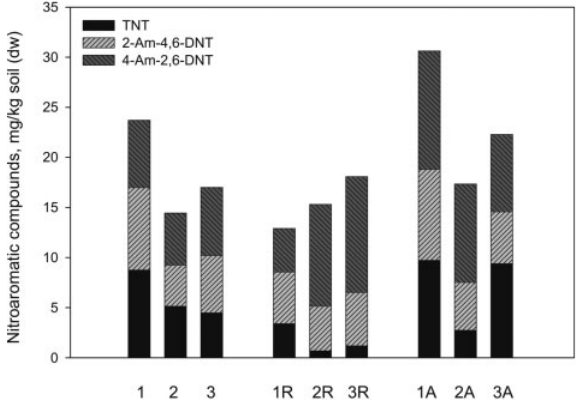
Fig. 1. Fate of TNT after 28 days of treatment (initial TNT concentration in soil 118 mg/kg). Sample codes are given in